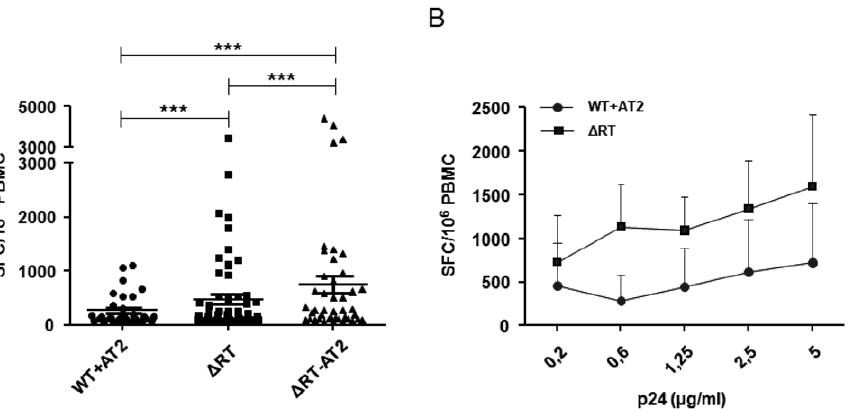
Figure 5. Immunogenicity of different viral constructions measured by ELISPOT responses. (A) Cryopreserved PBMCs from asymptomatic HIV seropositive individuals were tested for specific IFN- c secreting T cells by in vitro stimulation with different HIV virions (WT + AT-2, D RT and D RT + AT-2). PBMCs were pulsed with 200 ng/ml p24 equivalents in all cases. The response elicited by WT + AT-2, D RT and D RT + AT-2 virions (mean 6 SEM) is shown. The positivity threshold for each construct or antigen was defined as at least 50 SFC/10 6 PBMC and at least twice that of the control medium. The magnitude of response differed significantly between stimuli (***p , 0.001). (B) Four responder individuals were tested with different concentrations of WT + AT-2 and D RT virions (from 200 ng/ml to 5 m g/ml). The titration showed that the difference found between both stimuli was maintained, independently of the amount of virions used.